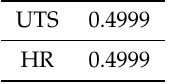
Table 14. Quality characteristic contribution of ultimate tensile strength and hardness.